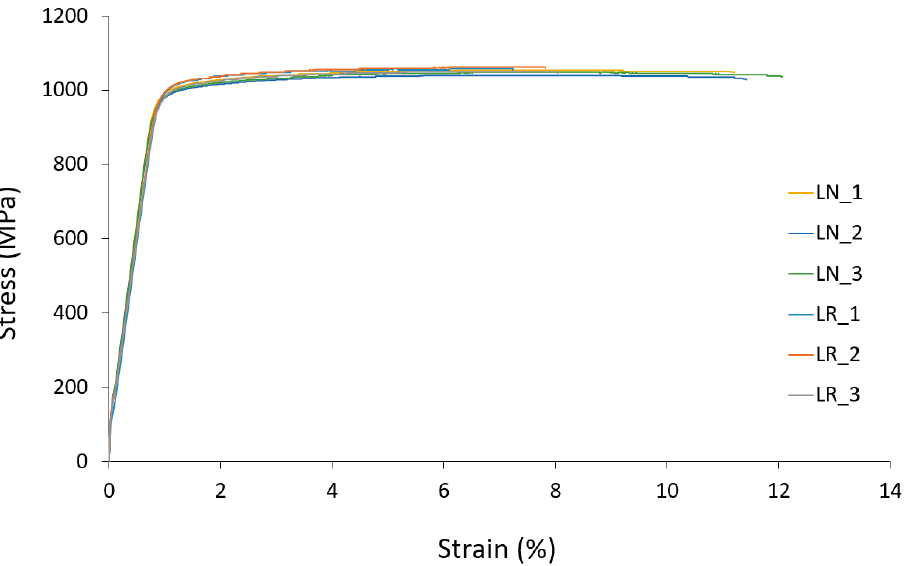
Figure 5. Comparison of tensile test results of 2-mm-diameter LPBF Ti-6Al-4V specimens fabricated with new and recycled powder.